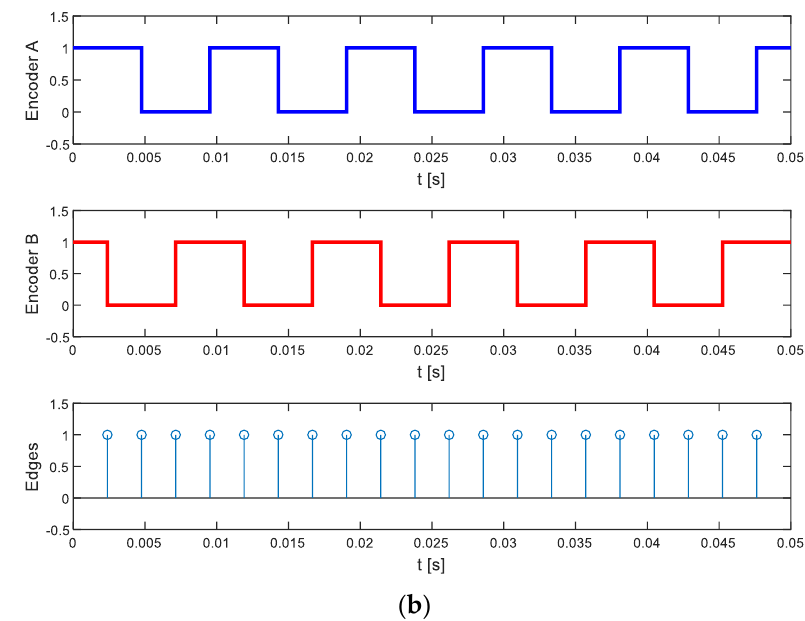
Figure 6. ( a ) Representation of the six-pole magnet of the encoder that is attached to the motor shaft and the two fixed hall-effect sensors, HA and HB, placed at a 90° phase offset. ( b ) Logical quadrature output signals generated by the rotation of the encoder and the edges detected by the microcontroller using the input capture module.